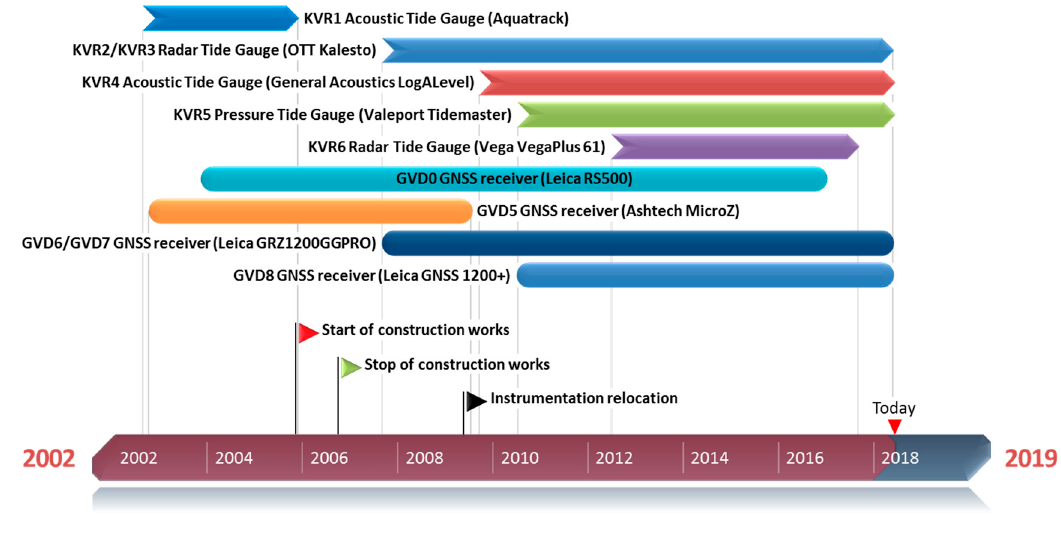
Figure 5. The operational status of the instrumentation (tide gauges, GNSS receivers) at the Gavdos Cal/Val site as of 2004.